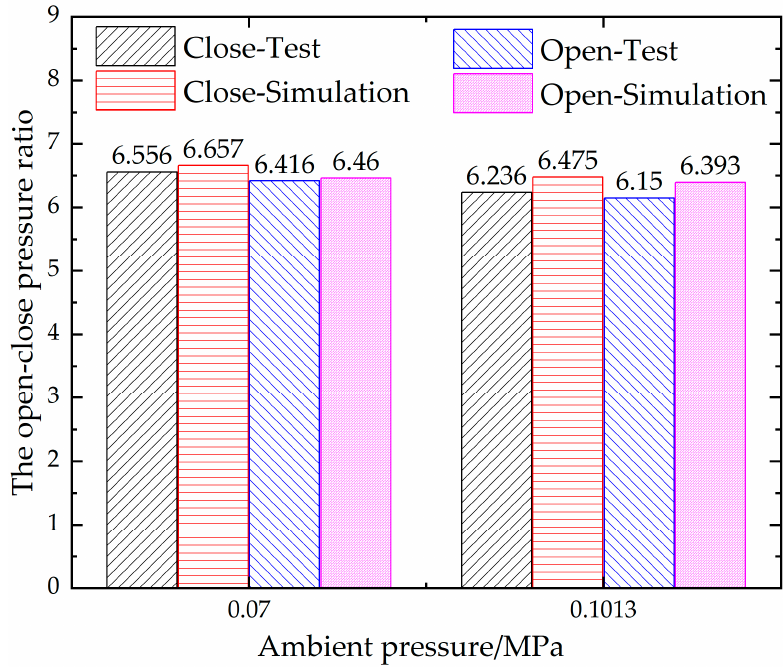
Figure 10. Results of vent valve test and simulated open-close pressure ratio.